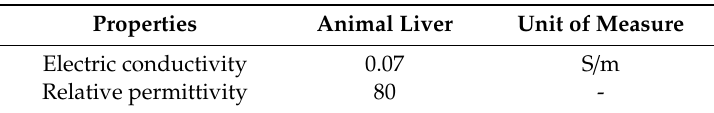
Table 6. Animal liver properties. Example of the properties considered to simulate the tissue / organ in which to insert the